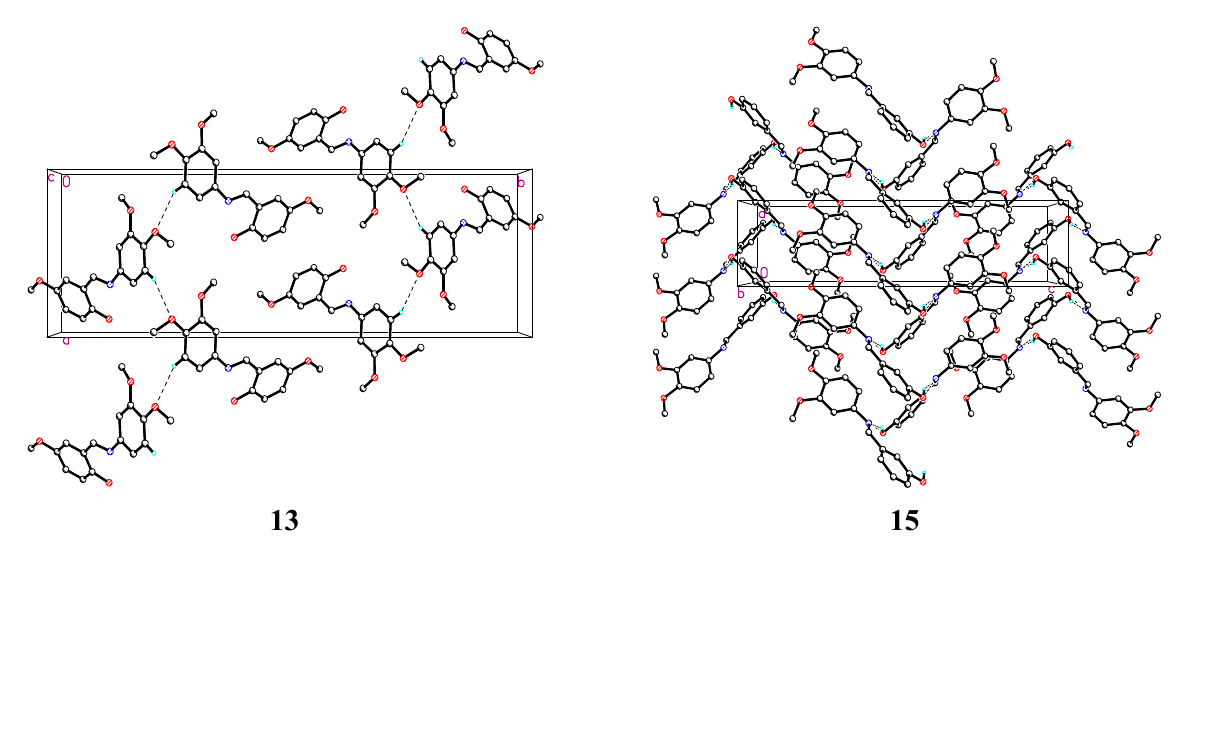
Figure 2. Crystal packing diagram for compounds 13 , 15 and 16